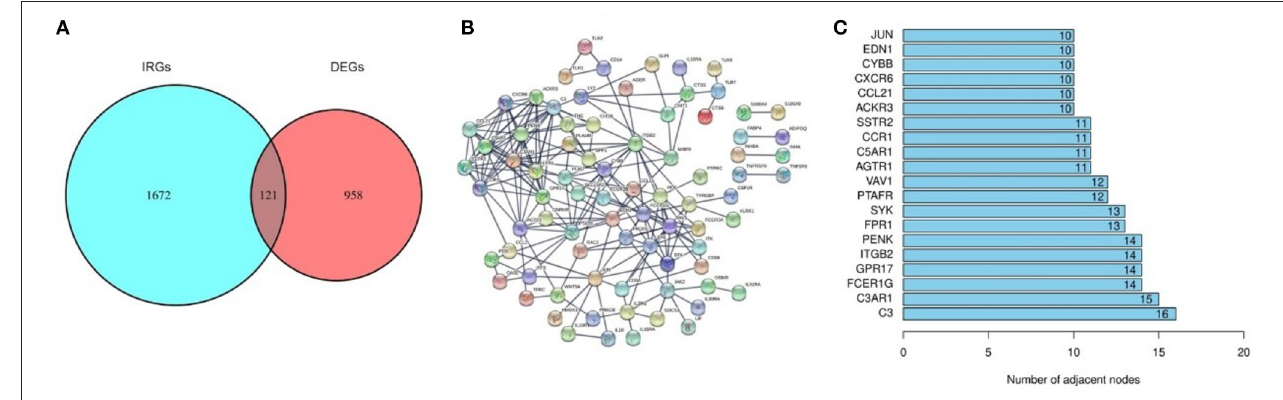
FIGURE 3 | The differentially expressed Immune-related genes and PPI network. (A) The intersection result of DEGs and IRGs. (B) The protein-protein interaction (PPI) network of 121 differentially expressed IRGs. (C) The top 20 genes with most adjacent nodes among the PPI network.